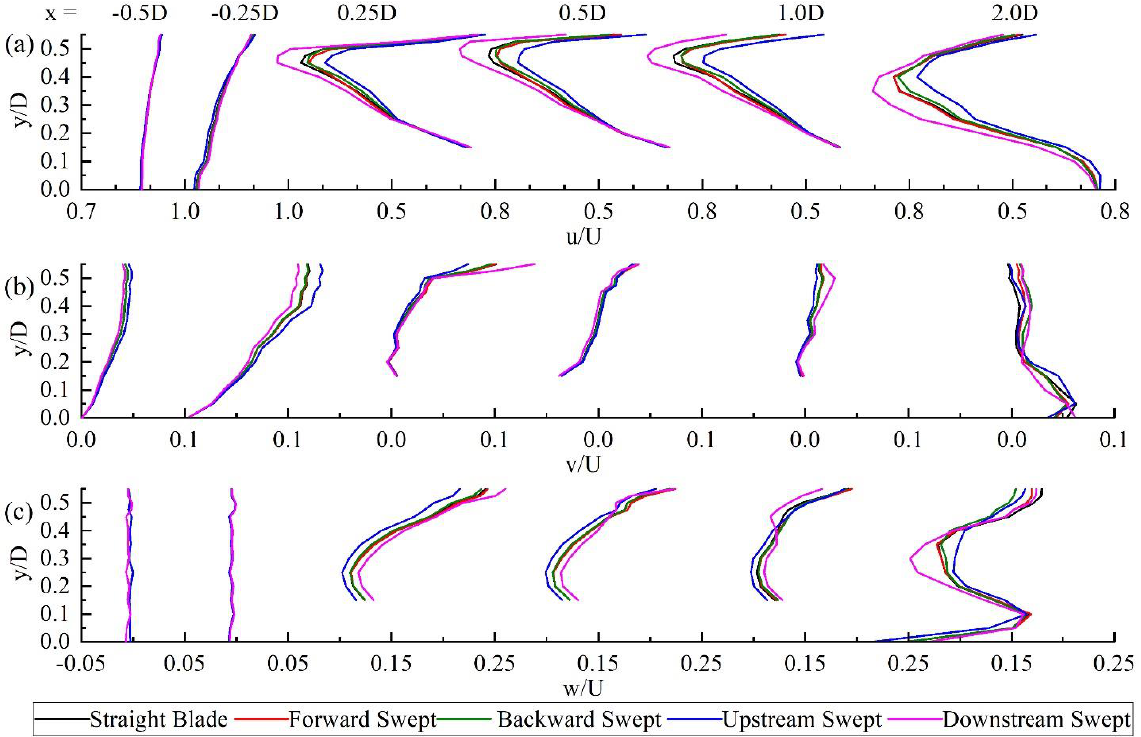
Figure 9. Time-averaged flow velocity distribution at TSR = 9, ( a ) for axial velocity, ( b ) for spanwise velocity, ( c ) for circumferential velocity.